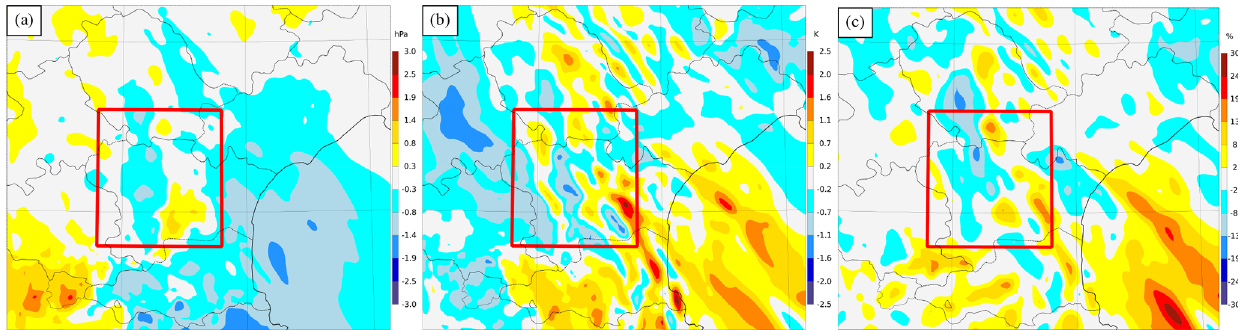
Figure 10. Average difference of the three most rainy AROME-EPS members based on 15:00UTC analysis on 14 October. The forecast time is 02:00UTC on 15 October 2018, i.e. in the middle of the period of interest. The anomaly is computed with respect to the ensemble mean at each point. (a) Mean sea level pressure (hPa), (b) moist potential temperature θ (cid:48) w (K) at 850hPa, and (c) relative humidity (%) at 850hPa.